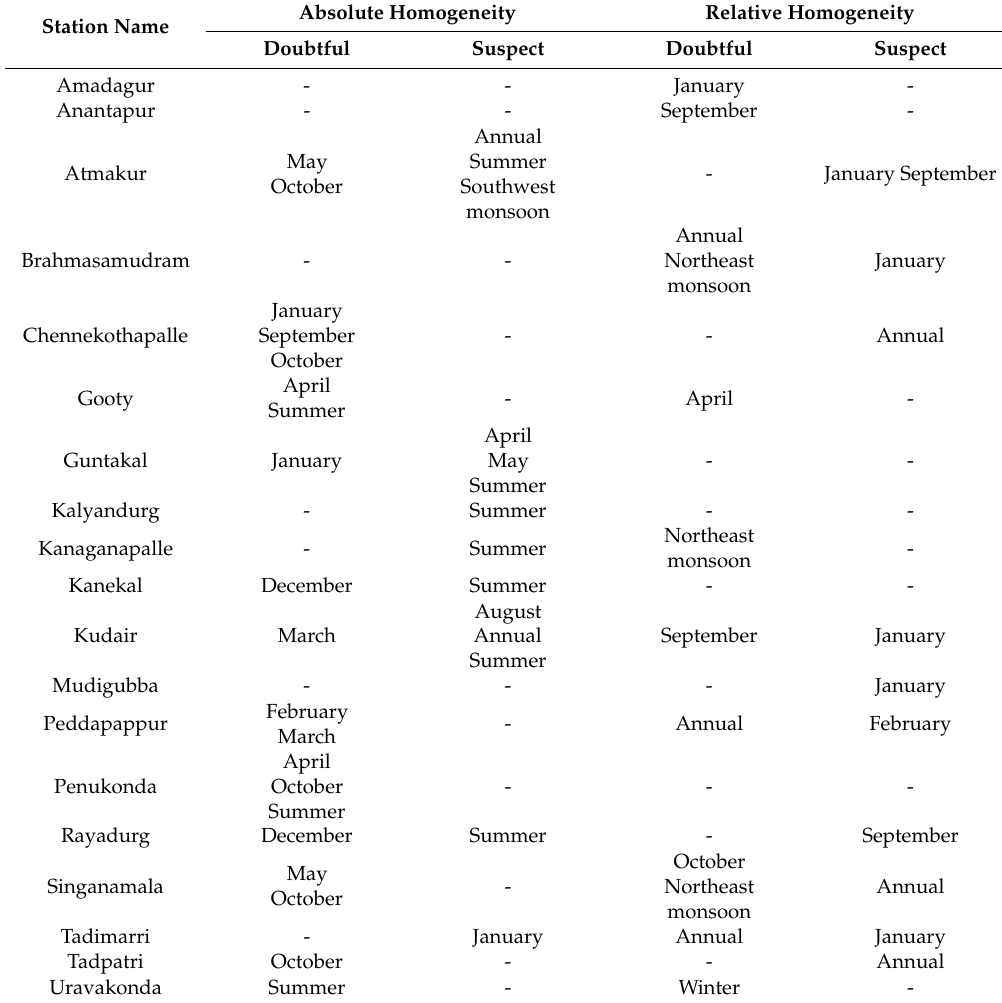
Table 2. Summary of homogeneity